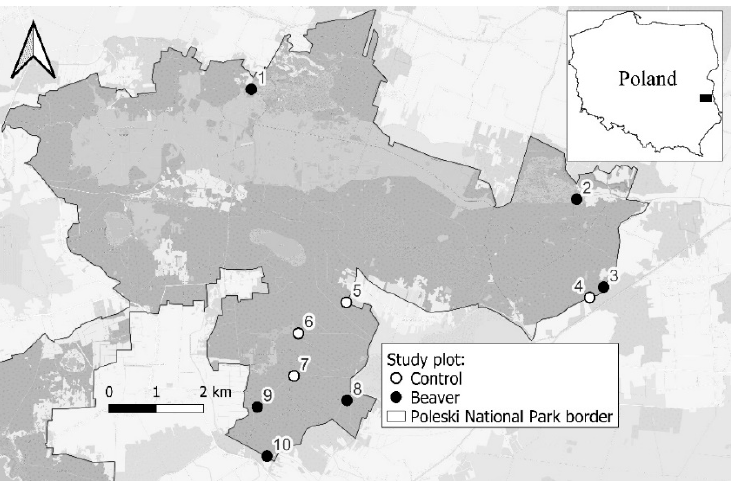
Figure 1. Location of survey plots in Polesie National Park. Ten survey plots were established. One plot was on a river (plot 2 on the Włodawska River) and nine plots were on drainage channels. The measurement plots were assumed to run along a straight section without meanders on the section of the Włodawka river. The width of the river and the channels is 4–7 m. Six survey plots were established at beaver dam sites, while four plots were established at sites where beaver have not been observed. Survey plot 10 was established in the vicinity of a human-made water gate. The beavers used the water gate as their own dam as trees felled by beaver were discovered near the water gate. In plots 4 and 7, the channel was the boundary between forest and non-forested land, while in plot 3 forest occurred more than 50 m from the banks of the channel. Only in plot 3, measurements were carried out in the non-forested land.